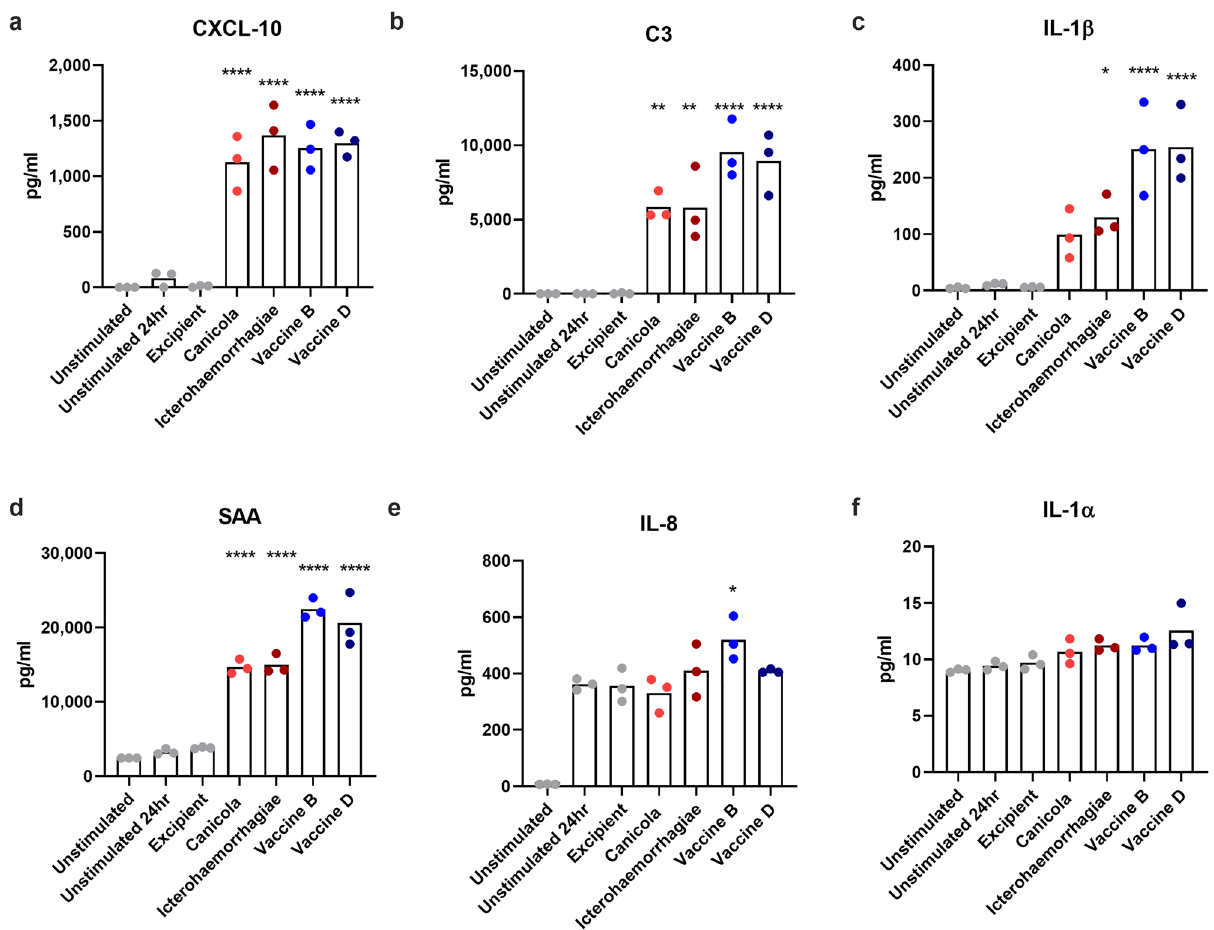
Figure 5. Expression of proteins associated with innate immune responses in the supernatant of stimulated 030-D cells. 030-D cells were stimulated for 24 h with whole-inactivated L. interrogans serogroup Canicola, Icterohaemorrhagiae, bivalent vaccine B, its excipient, or bivalent vaccine D. The supernatants were assayed for the presence of ( a ) CXCL-10, ( b ) C3, ( c ) IL-1β, ( d ) SAA, ( e ) IL-8 and ( f ) IL-1α. Stimulations were performed in triplicate. Dots represent values of each replicate and bars represent the mean. Three independent experiments were performed with similar outcome. A representative experiment is shown. A one-way ANOVA combined with Dunnett’s multiple comparisons test was used to test for significance. *p < 0.05, **p < 0.01, ****p < 0.0001 compared to the unstimulated control 24